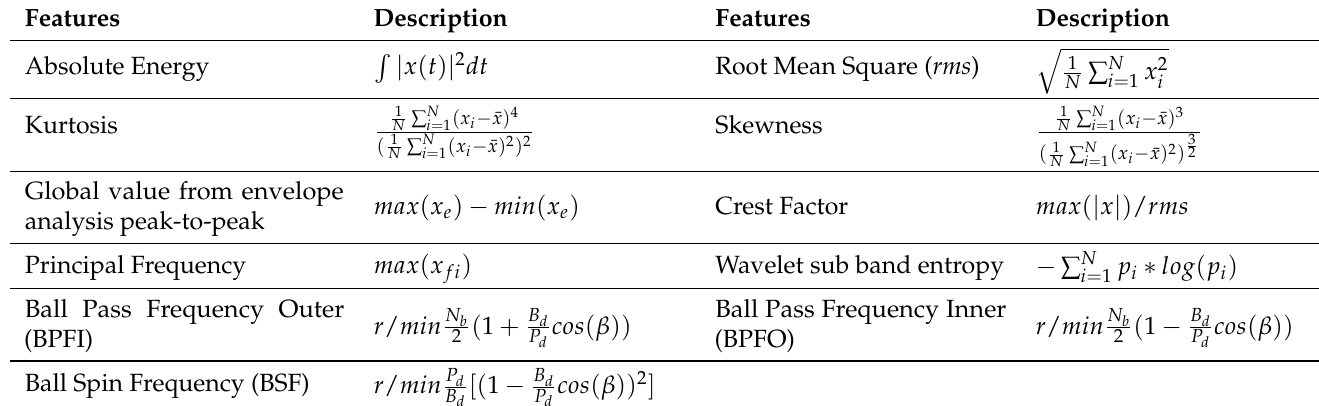
Table 1. Features extracted from the vibration